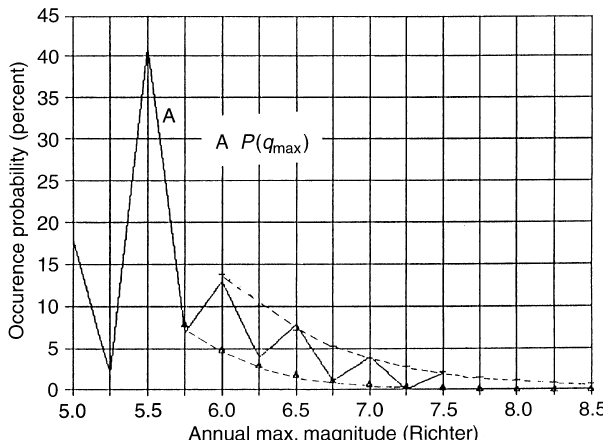
Fig. 12. Distribution of annual max. quake